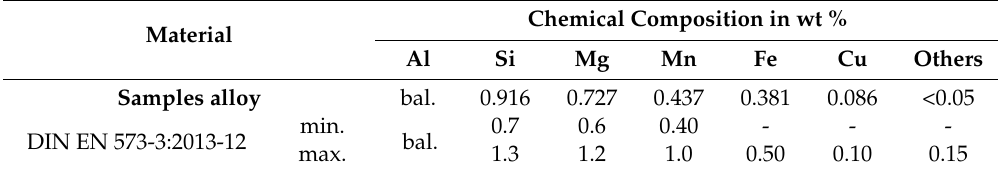
Table 1. Chemical analysis of the samples in wt % in comparison with the limitations of the DIN EN 573-3:2013-12.